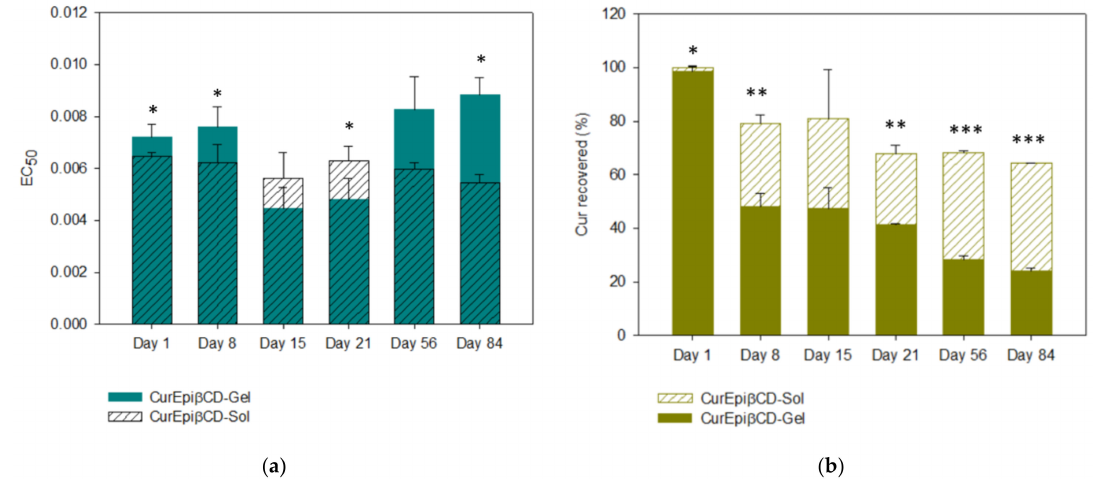
Figure 6. Antioxidant activity ( a ) and percentage of Curcumin recovered ( b ) from optimized hydrogel (CurEpi β CD-Gel) and solution (CurEpi β CD-Sol) over time. Data are expressed as the mean ± SD. The mean value of CurEpi β CD-Gel was significantly different compared with the control group, CurEpi β CD-Sol (* p < 0.05; ** p < 0.01; *** p < 0.001; Student’s t -test).